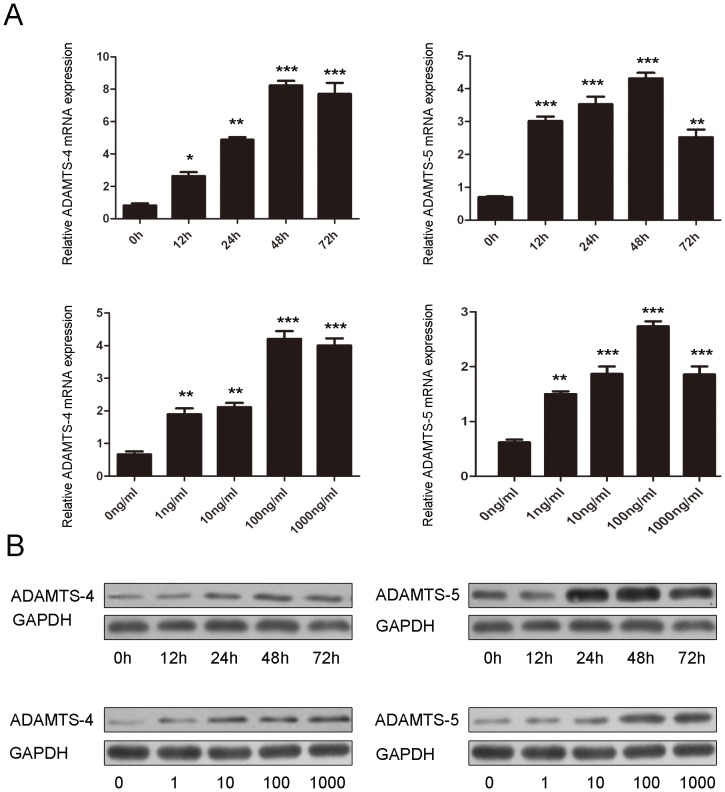
Leptin promoted ADAMTS-4 and ADAMTS-5 expression.(A) The effect of leptin on ADAMTS-4 and ADAMTS-5 mRNA expression assessed using Real-time RT-PCR. For the dose-dependent studies, NP cells were treated with either medium only or varying concentrations of leptin (1–1000 ng/ml) for 24 h. For the time-depent studies, NP cells were treated with either medium only or leptin (10 ng/ml) for varing time intervals (0–72 h). (B) The effect of leptin on ADAMTS-4 and ADAMTS-5 protein expression was detected with western blotting ananlysis using GAPDH as an internal control. Error bars represent standard deviration. The medium was changed every day. *p<0.05, ** p<0.01, and ***p<0.001.